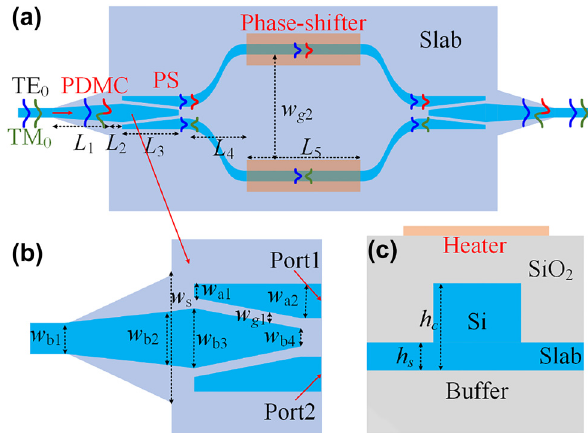
Figure 1: Schematic configuration of the proposed polarization switch. (a) The top view; (b) the PDMC and PS regions; and (c) the cross- section of the ridge waveguide of the phase